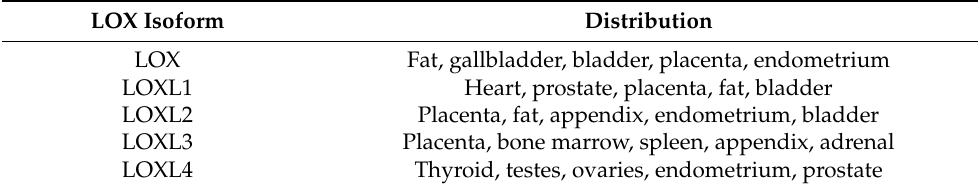
Table 1. RNA-seq of lysyl oxidase in normal tissue samples. LOX Isoform Distribution LOXL1 Heart, prostate, placenta, fat, bladder LOXL2 Placenta, fat, appendix, endometrium, bladder LOXL3